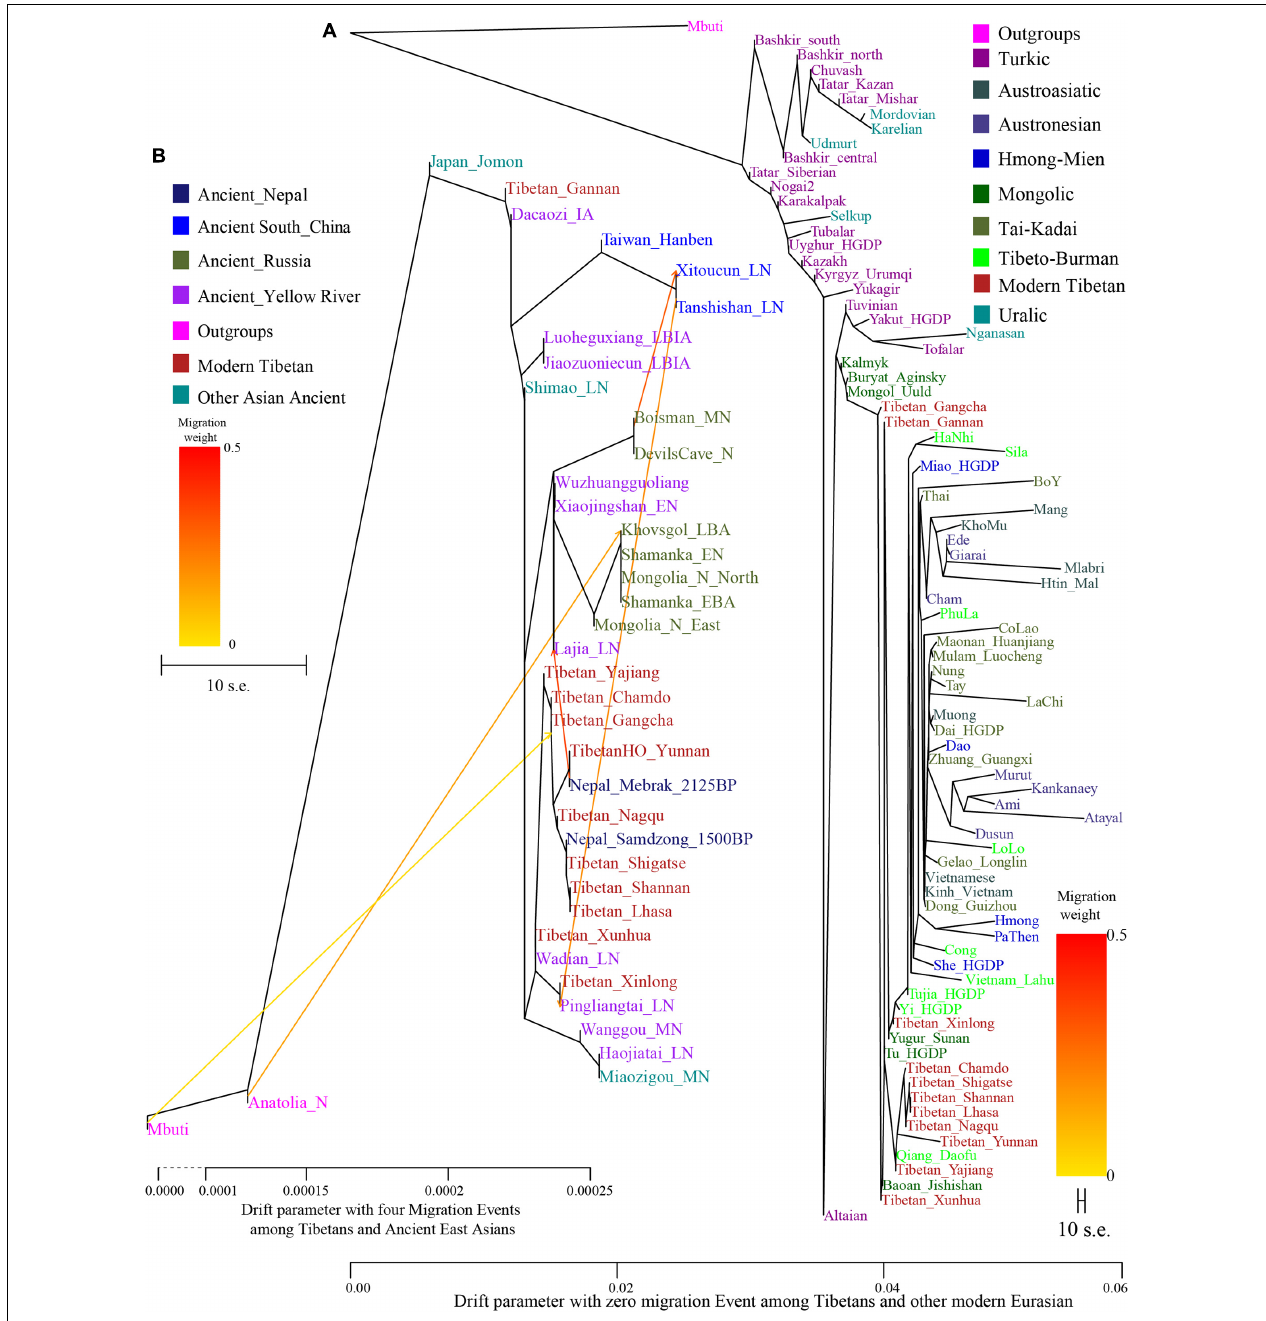
FIGURE 2 | Maximum likelihood phylogeny reconstruction based on the genetic variation from both modern Tibetan and Eurasian modern reference populations. (A) , modern Tibetan and Neolithic-to-historic East Asian (B) . Mbuti was used as the root. Focused on the phylogenetic relationship among all modern populations, we used the patterns of genetic relationship with zero migration events. And evaluating the evolutionary history among modern Tibetan and ancient Chinese, we included three migration events. To better present our result, the drift branch length of Mlabri was shortened as the third of the truth drift branch length due to the strong genetic drift that occurred in